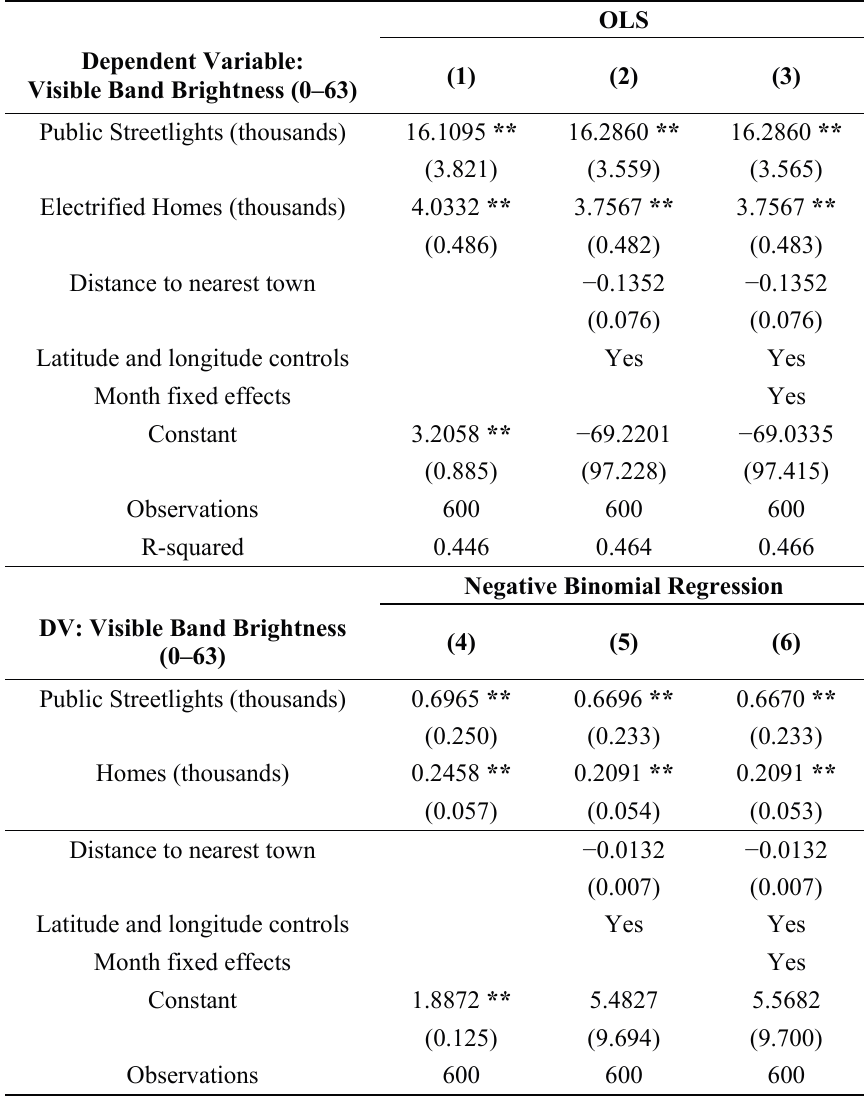
Table 5. Determinants of nightly DMSP-OLS light output. Data from 200 Vietnam villages and monthly composite images, August–October